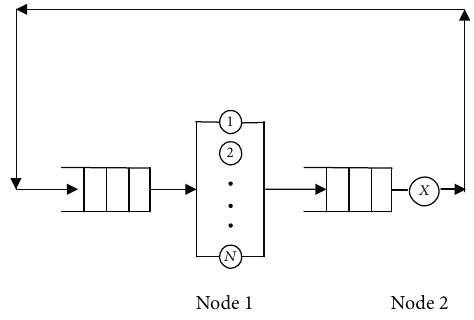
Figure 1: Finite population